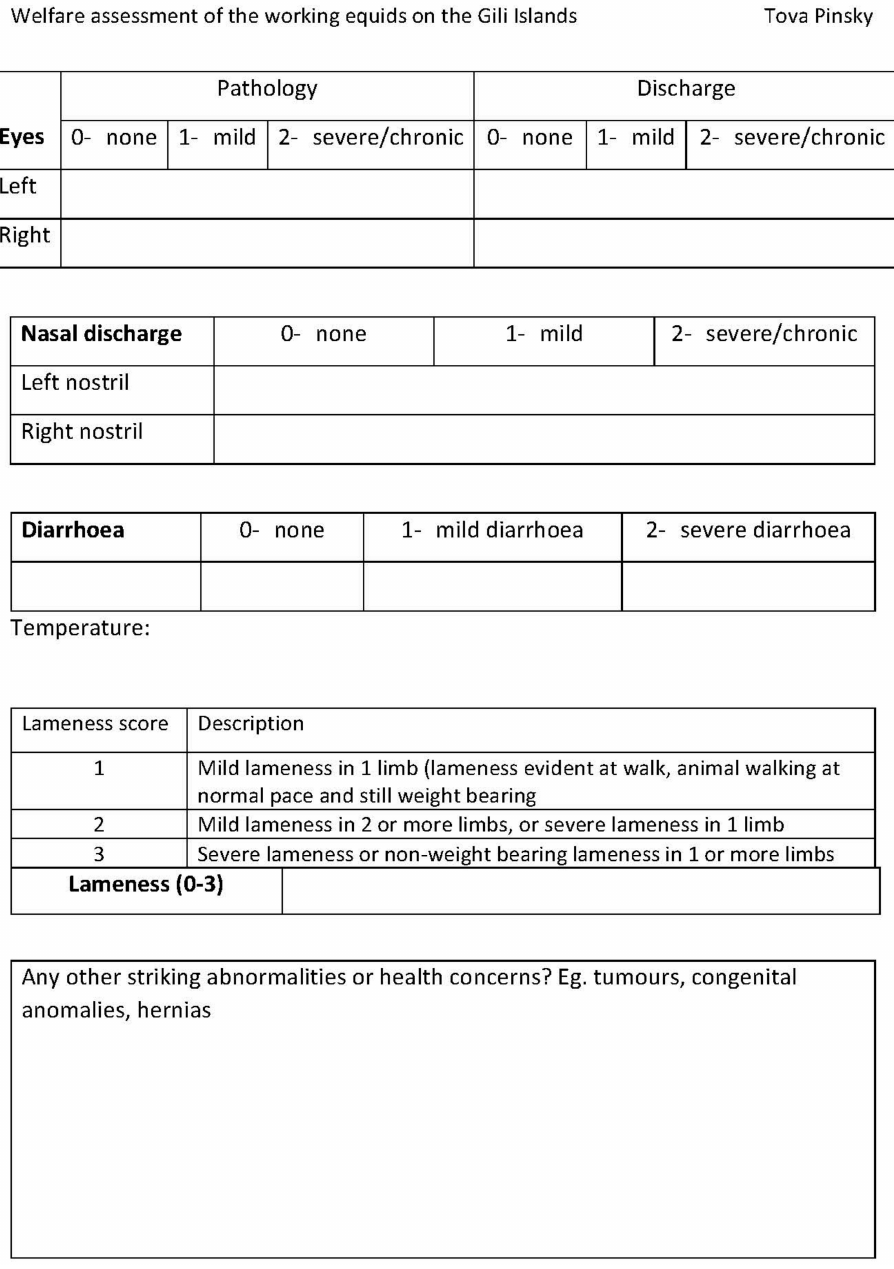
Figure A2. Equine health examination form used to collect data on physical examination